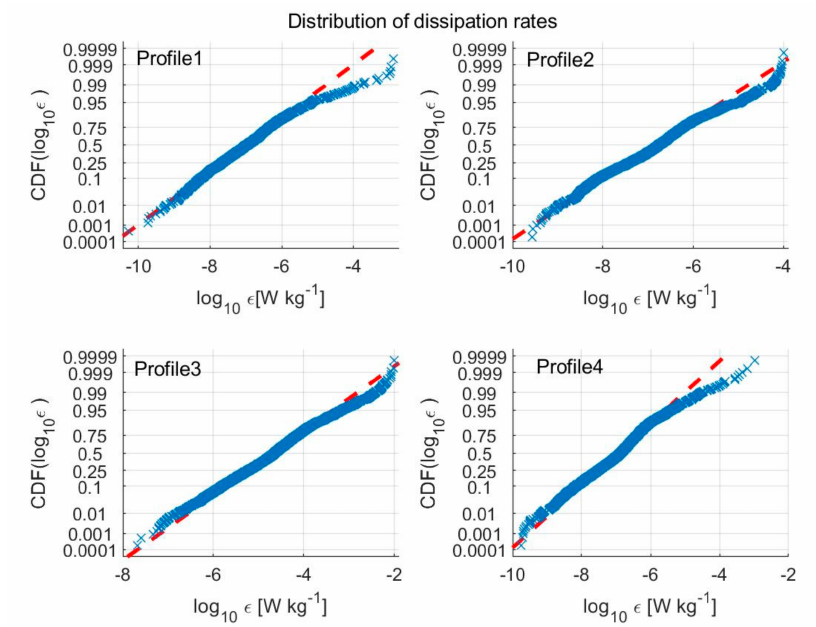
Figure 10. Cumulative probability distribution functions of dissipation rates for four profiles. The x -axis is the dissipation rates ( ε ) of turbulence energy and the y -axis is the probability, which ranges from 0 to